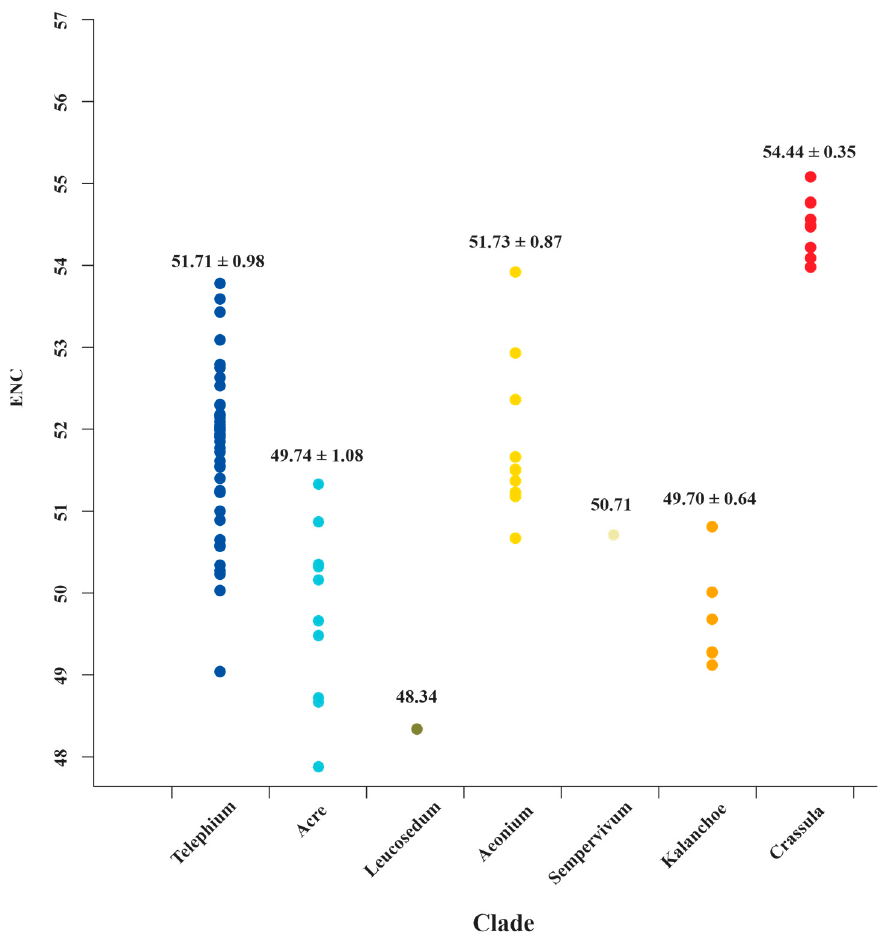
Figure 6. The ENC value distributions of matK for 7 clades of Crassulaceae. The mean values with standard deviations are labeled.